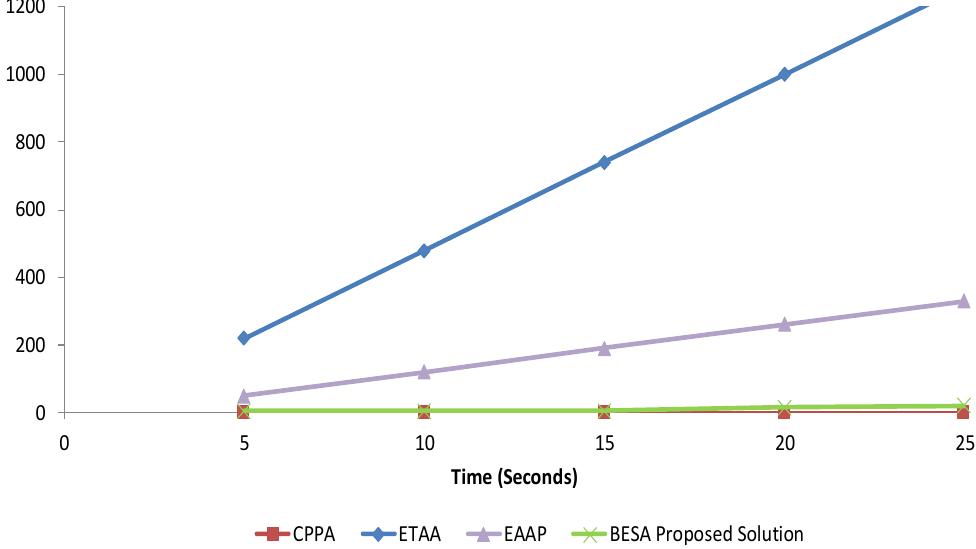
Figure 9. Comparison of BESA computation cost of message verification with that of existing schemes.